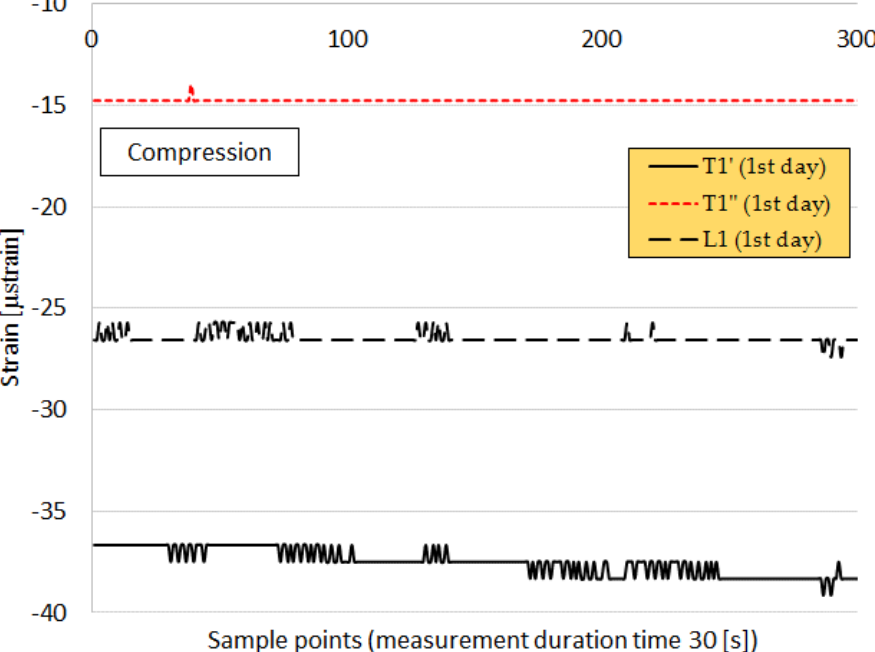
Figure 7. Strain values of sensors T1’, T1’’, and L1 during the construction of CyPaTs asphalt pavement on the first day at a temperature of 64 °C on the surface of the first base layer AC-14.